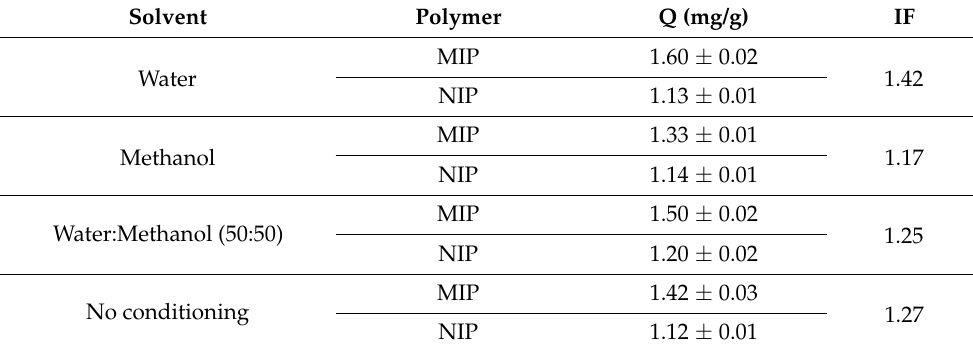
Table 1. Evaluation of the preconditioning using different solvents (n =